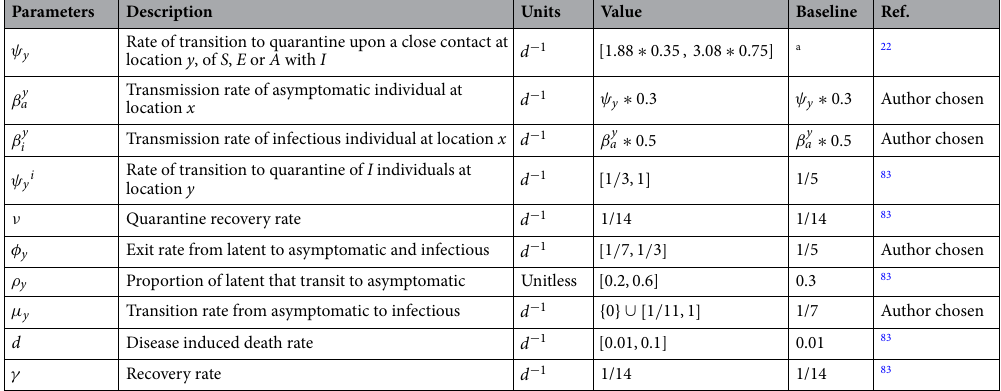
Table 3. Description of epidemiological parameters and parameter values. a Average numerical value, the breakdown by blocks is listed in Table 4, found at the end of the “Numerical results” section. d: = day, 1